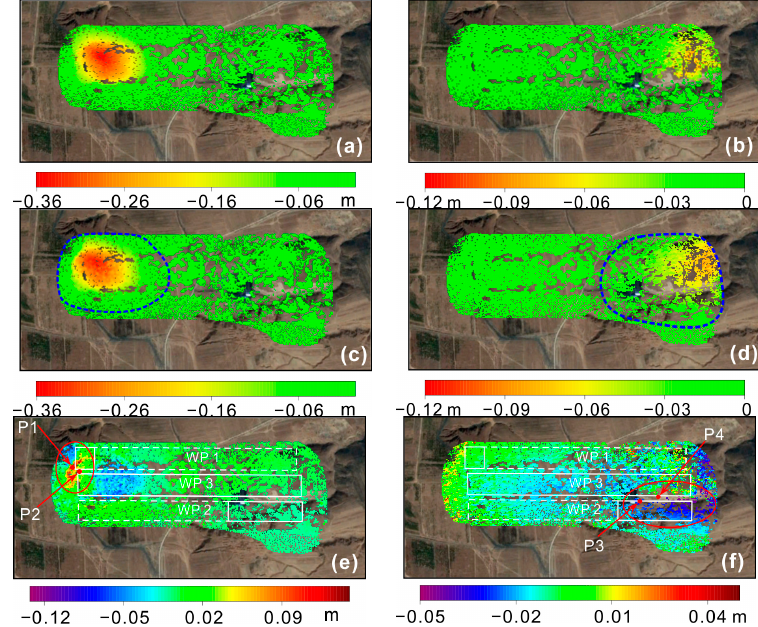
Figure 8. ( a , b ) InSAR-derived subsidence from 15 December 2007 to 30 January 2008 and from 16 September to 17 December 2008. ( c , d ) Logistic model derived synchronous subsidence. ( e , f ) Differences between the two sets of results. The red points in ( e ) and ( f ) are selected for further analysis.